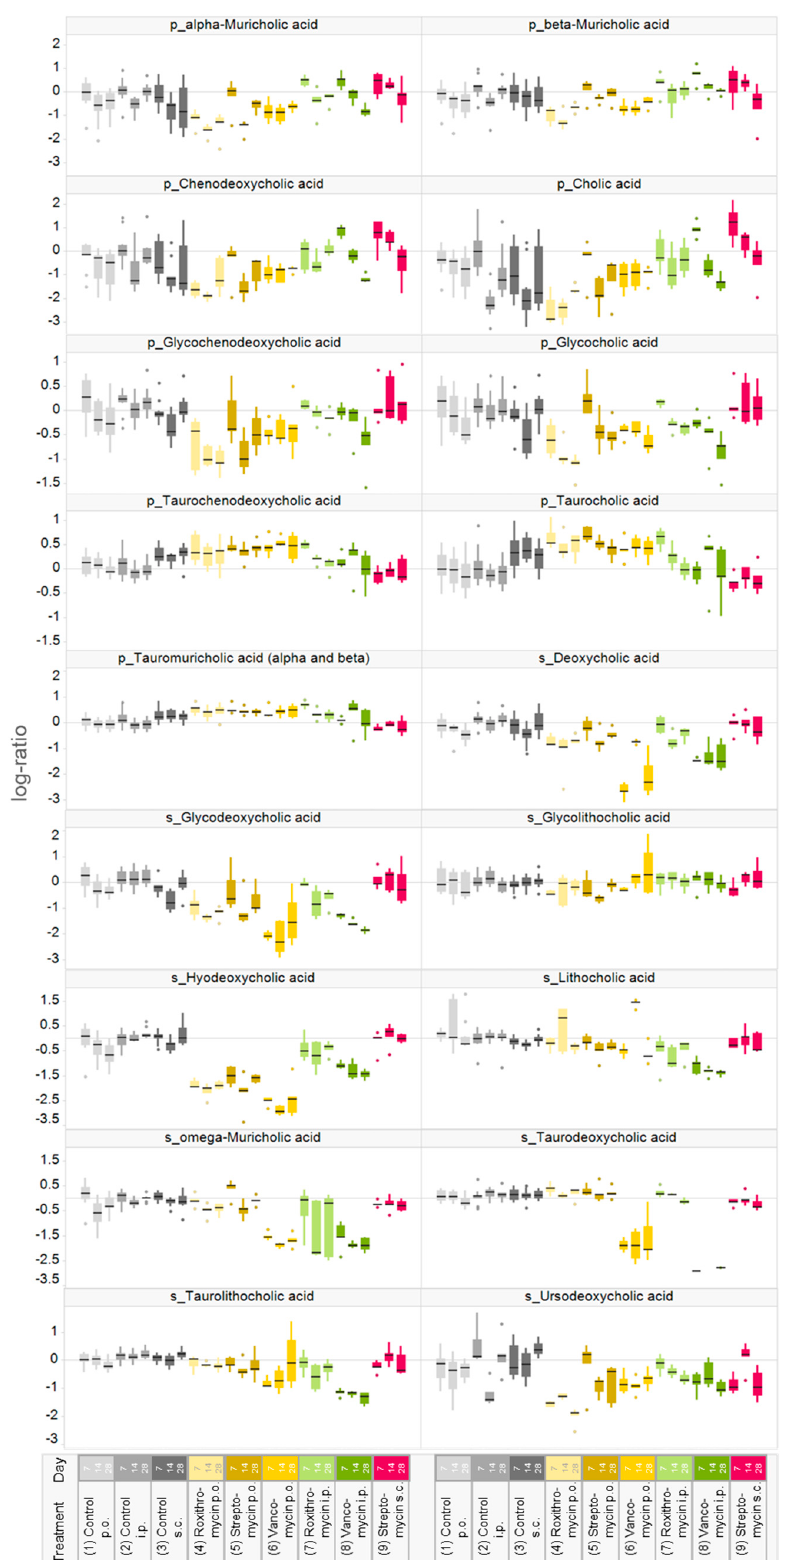
Figure 4. Plasma bile acid levels of male Crl/Wi(Han) rats treated orally or parenterally with vancomycin, streptomycin or roxithromycin. Input values are log10-transformed fold-changes relative to the feeding control. p_ indicates primary bile acid s_ secondary bile acid. The black horizontal line in each boxplot represents the group median value. p.o., per os (by mouth); i.p., intraperitoneal; s.c., subcutaneous.